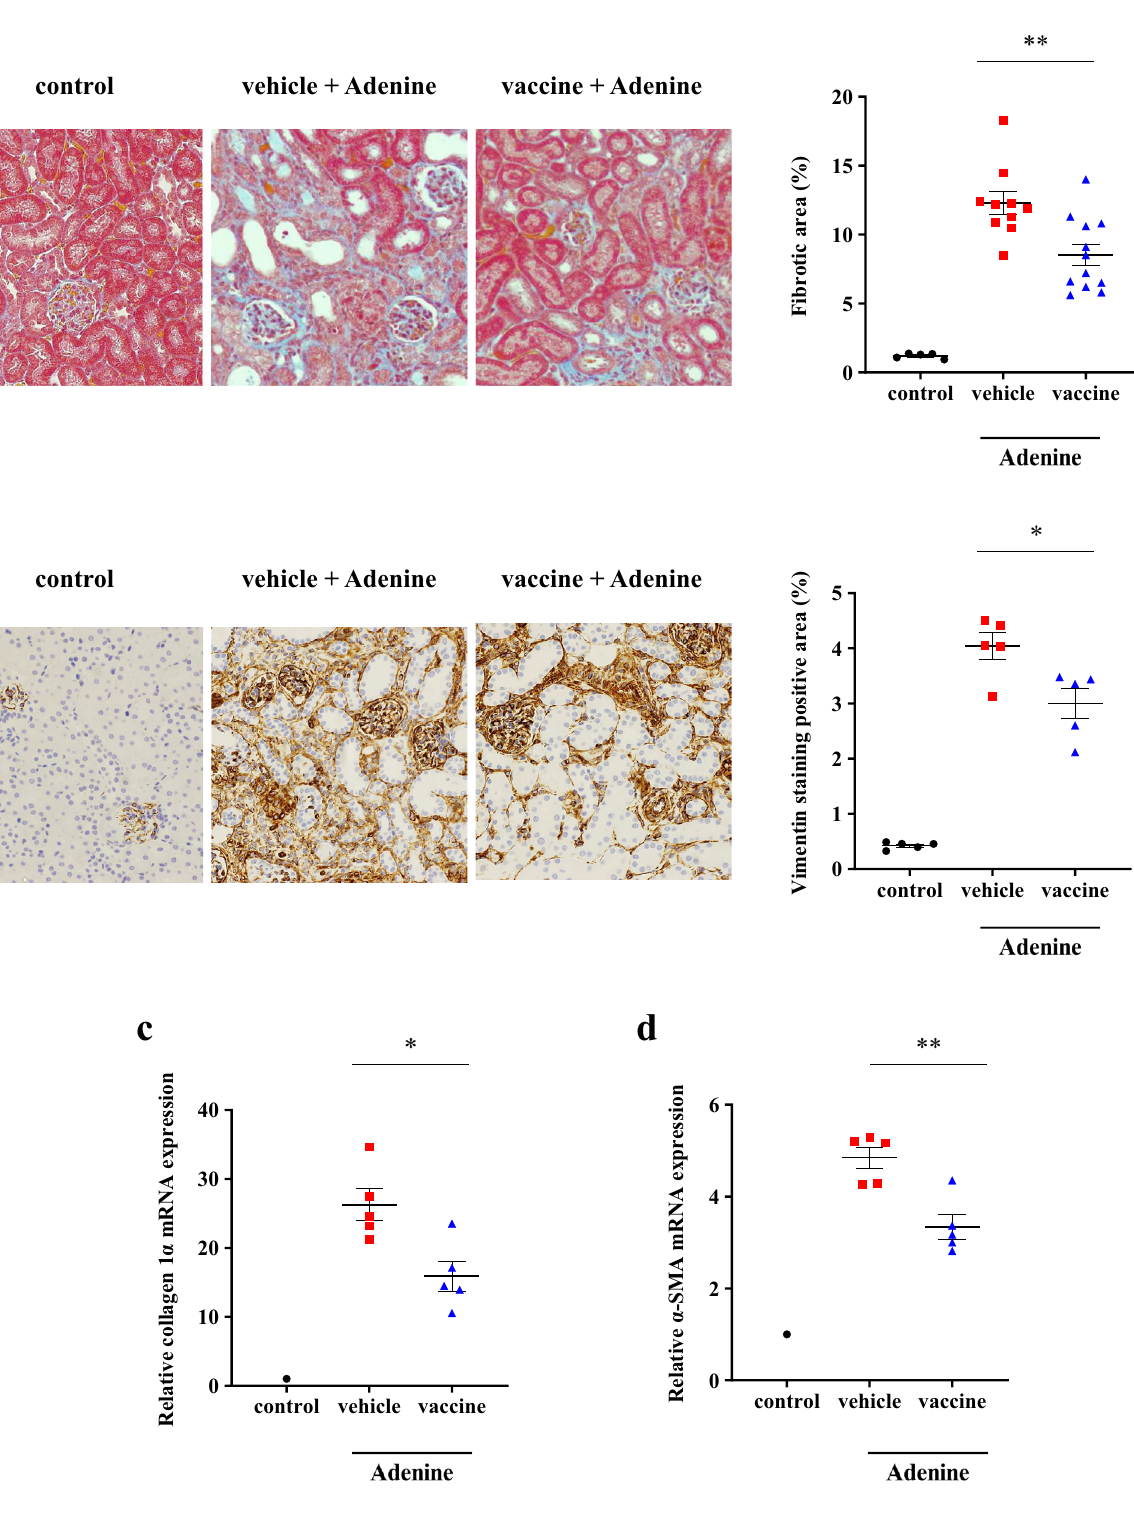
Figure 3. Effects of the CTGF vaccine on renal interstitial fibrosis in the adenine-induced CKD model. Male C57BL/6 J mice were inoculated with the KLH vehicle or CTGF vaccine. Mice were euthanized after feeding a rodent diet containing 0.2% adenine for 3 weeks ( n = 10–12/group). Kidney Sects. (4 µm) were stained with ( a ) Masson’s trichrome and ( b ) vimentin. Ten unselected fields per mouse were captured at × 200 magnification, and stained areas were quantified as a percentage of the total area. The relative mRNA expressions of ( c ) collagen 1α and ( d ) α-SMA normalized to β-actin were measured with real-time PCR ( n = 5/group). Error bars show mean ± SEM. Statistical difference between the KLH vehicle and CTGF vaccine group was determined by using Student’s t -test. ** P < 0.01 as compared with the